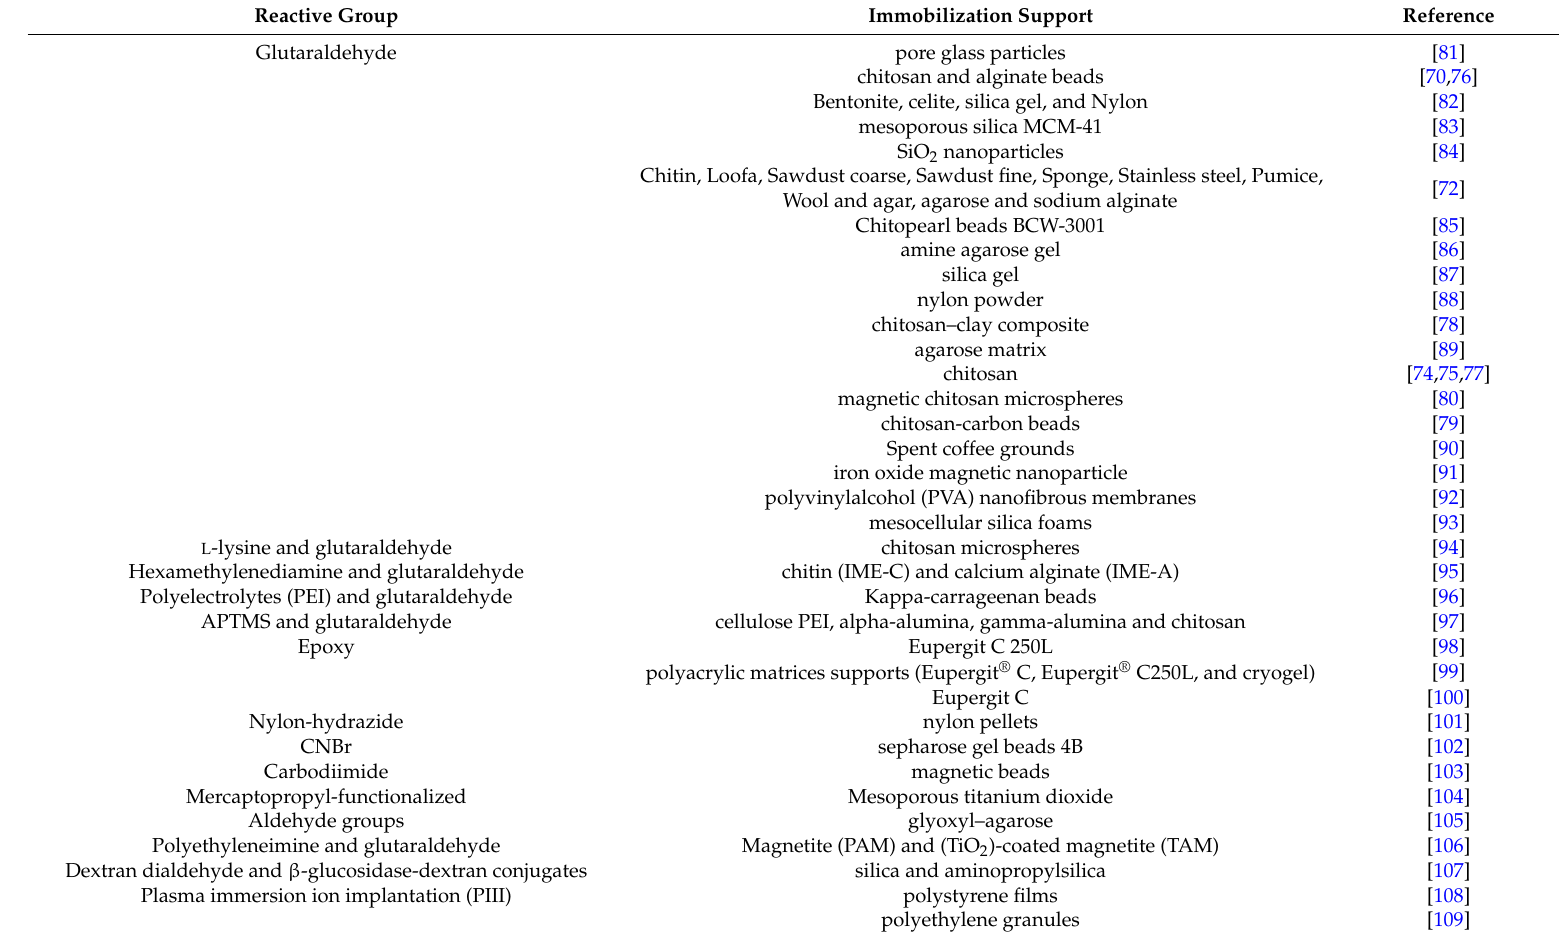
Table 1. Characteristics of different covalent binding based immobilizations of β